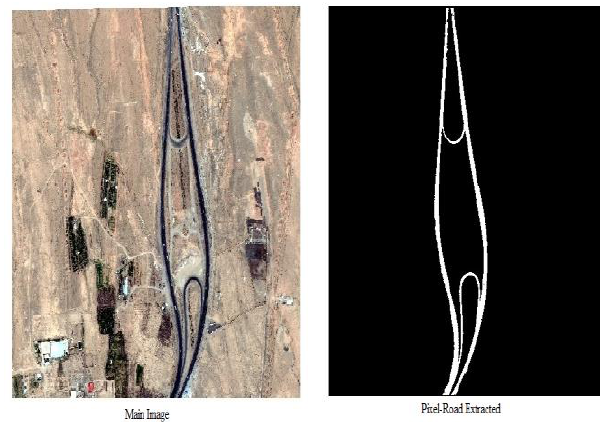
Figure 2. Road extracted from Google Earth image After extracting road pixels (Fig. 2), vector-image conflation was done automatically. To evaluate accuracy, road was extracted manually from image as a reference (Fig. 3) so that it can be used to evaluate the precision of conflation.